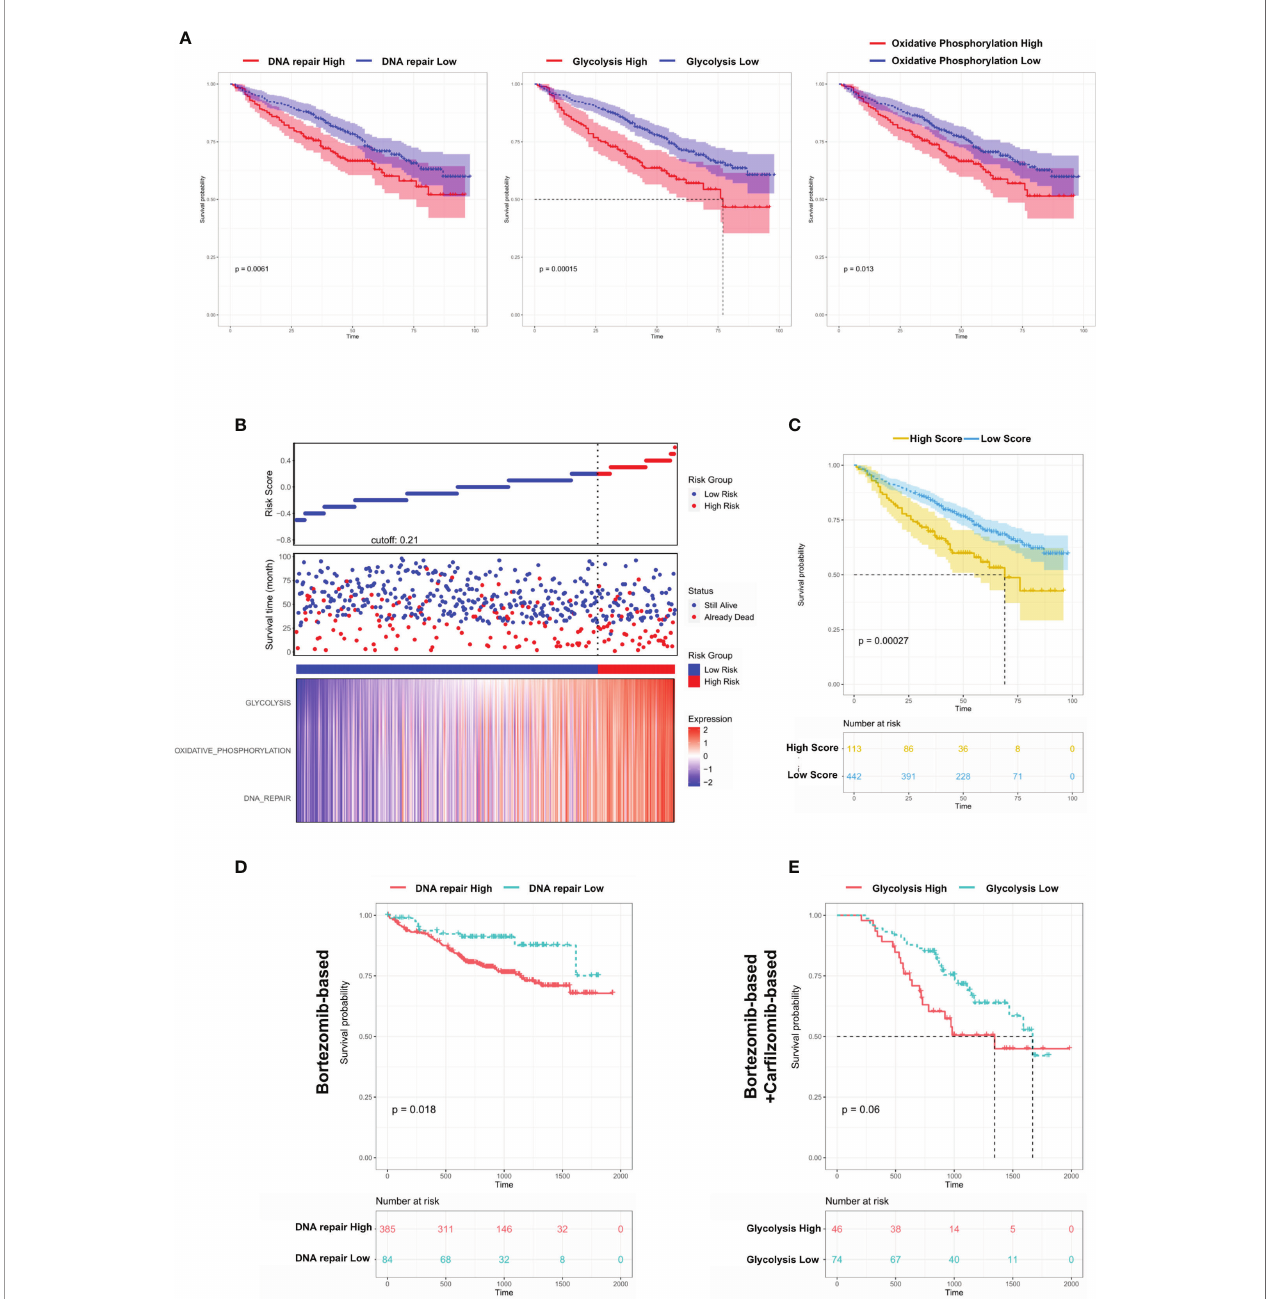
FIGURE 7 | Dysregulated biological processes in Group 1 MM cases shorten survival and affect therapeutic responses. (A) Kaplan – Meier survival curves comparing the overall survival in MM cases with high or low expression of DNA repair/glycolysis/oxidative phosphorylation scores in the GSE24080 dataset. (B) Distribution of risk score, OS, survival status (red dots indicate dead; green dots indicate alive), and the three pathway scores ’ heatmap in GSE24080. (C) Kaplan – Meier survival curves comparing the overall survival in MM cases with high- or low-risk score in the GSE24080 dataset. (D) The survival rate of MM patients with high/low DNA repair score treated with Bortezomib-based therapy. (E) The survival rate of MM patients with high/low glycolysis score treated with Bortezomib-based+Car fi lzomib-based